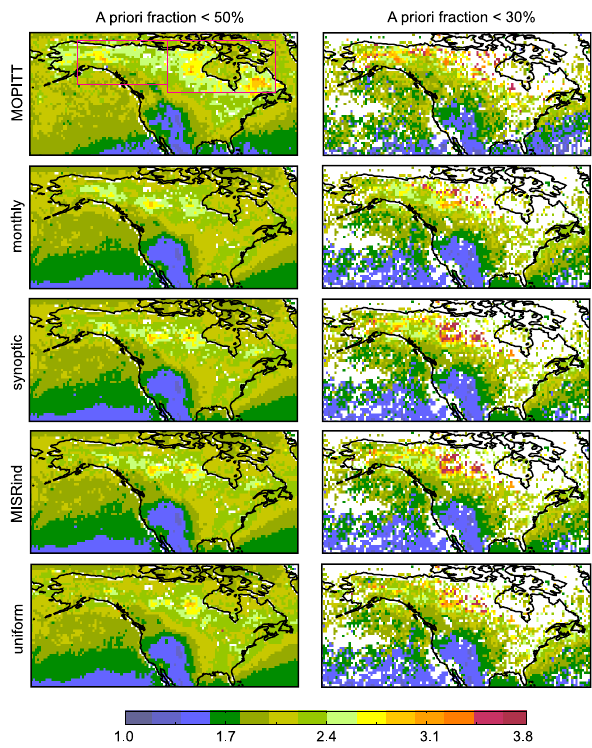
Fig. 10. Comparison of 3-month (June–August 2004) average CO column (10 18 molec/cm 2 ) from GEOS-Chem simulations and from MOPITT retrievals. MOPITT averaging kernel and the a priori CO profile were applied to model results. Two a priori critical fractions (50% and 30%) were used to filter out samples with large a priori